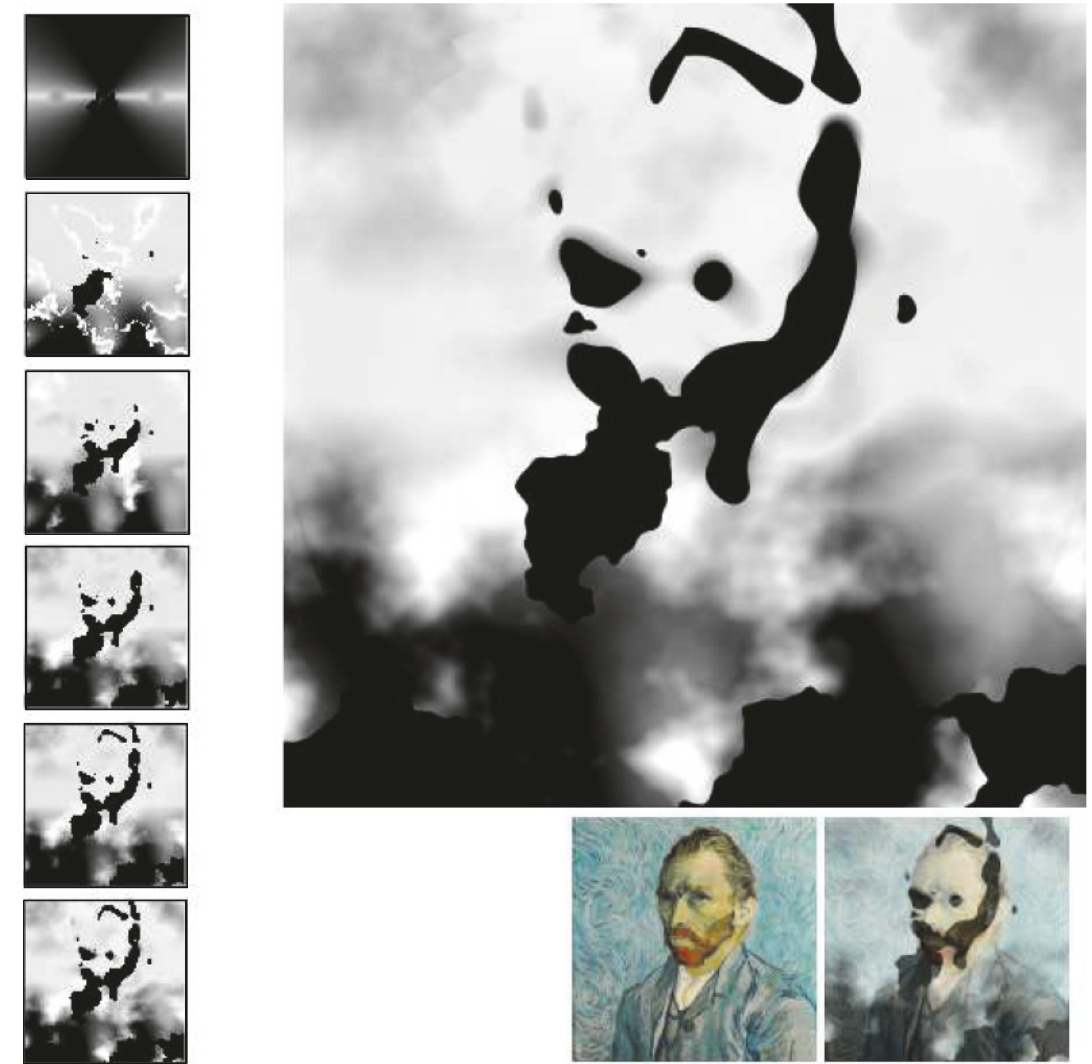
Figure 12: Produced image highlights; noisy language, no 𝑋 ; Van Gogh. On the left, we can see a snapshot of the candidate at every 20 generations. An evolutionary strategy has emerged which gradually applies layers and refines noise operators. The candidate is viewed atop the target image with partial transparency in the bottom